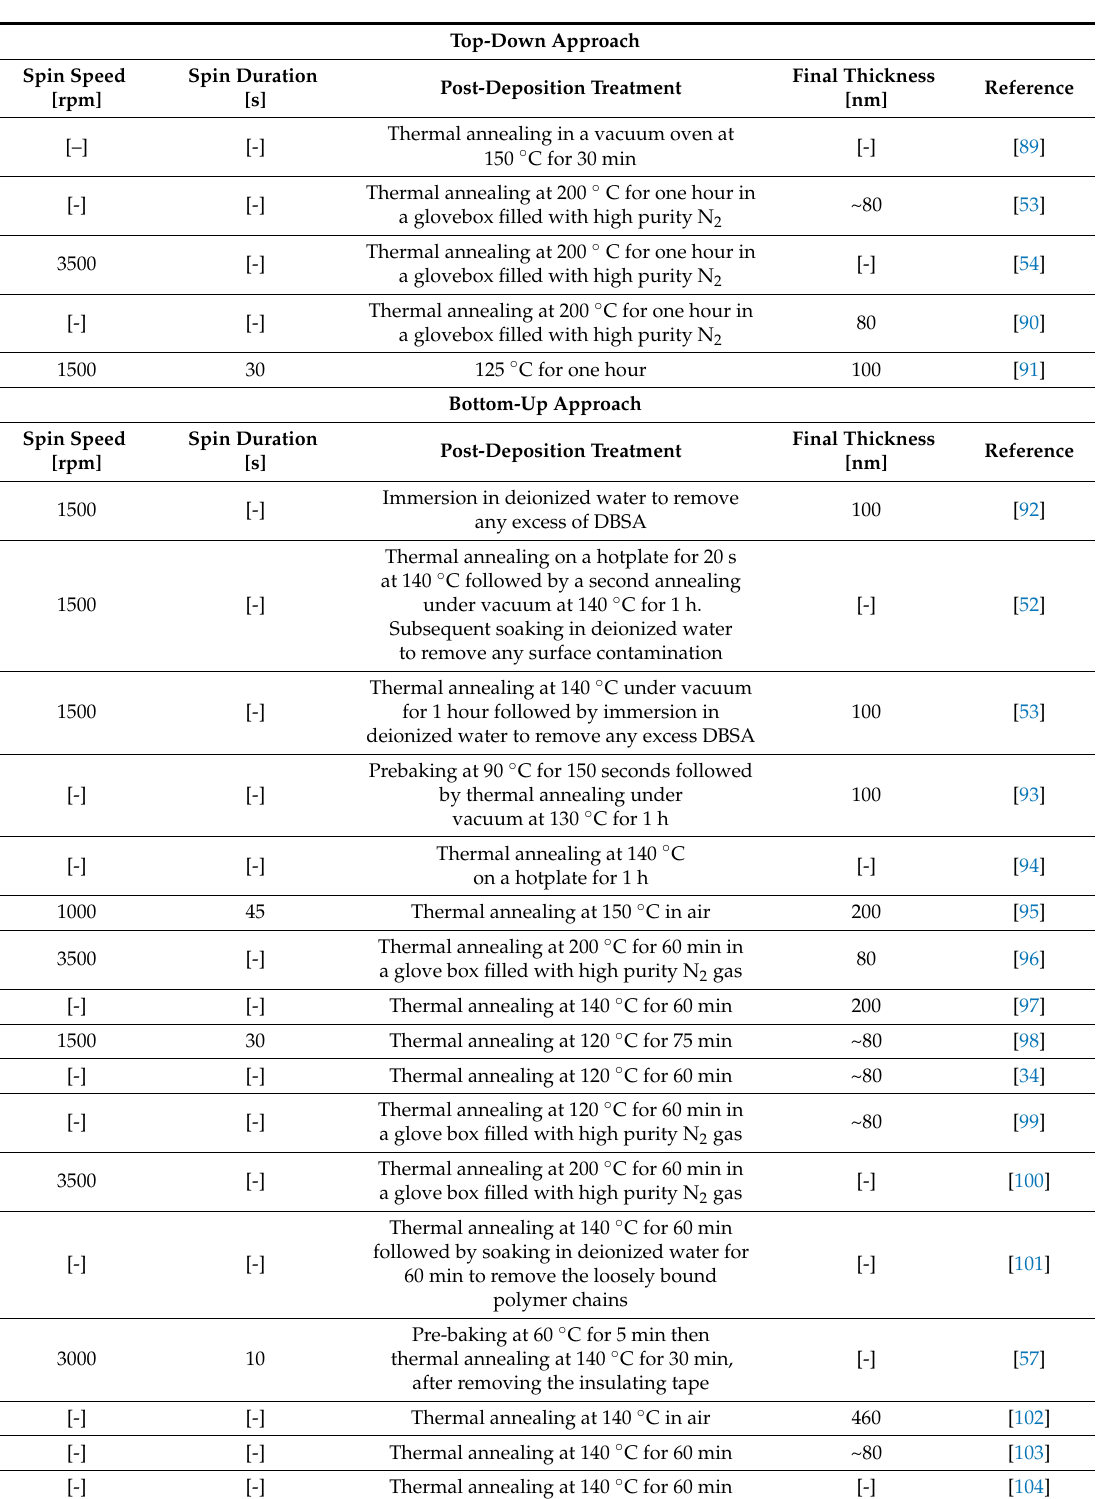
Table 1. Most important characteristics of spin-coating fabrication